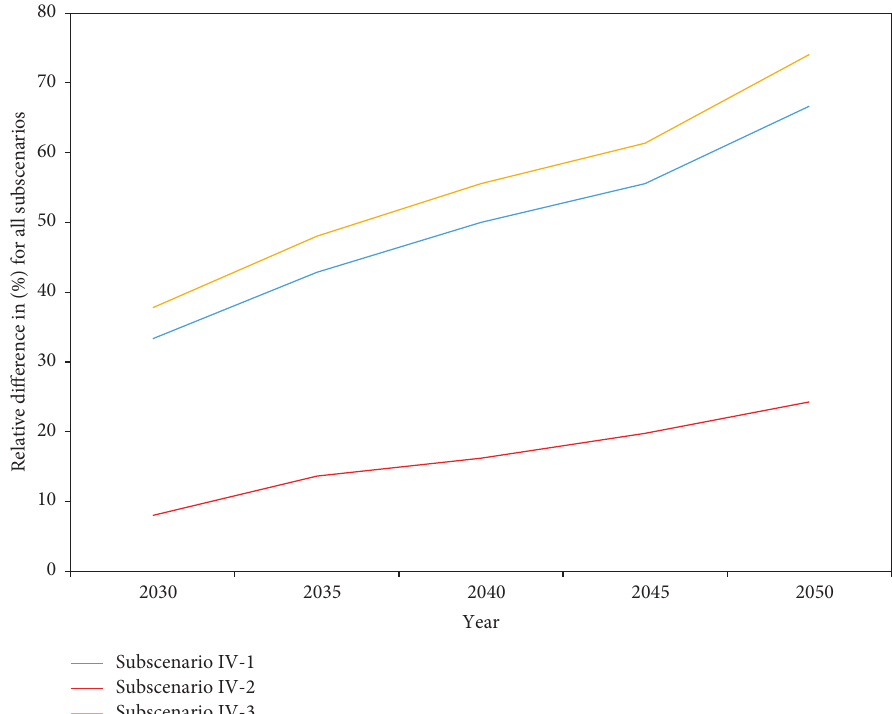
Figure 23: Percentage of increased capacity of each nuclear power option after CO IV-1 to